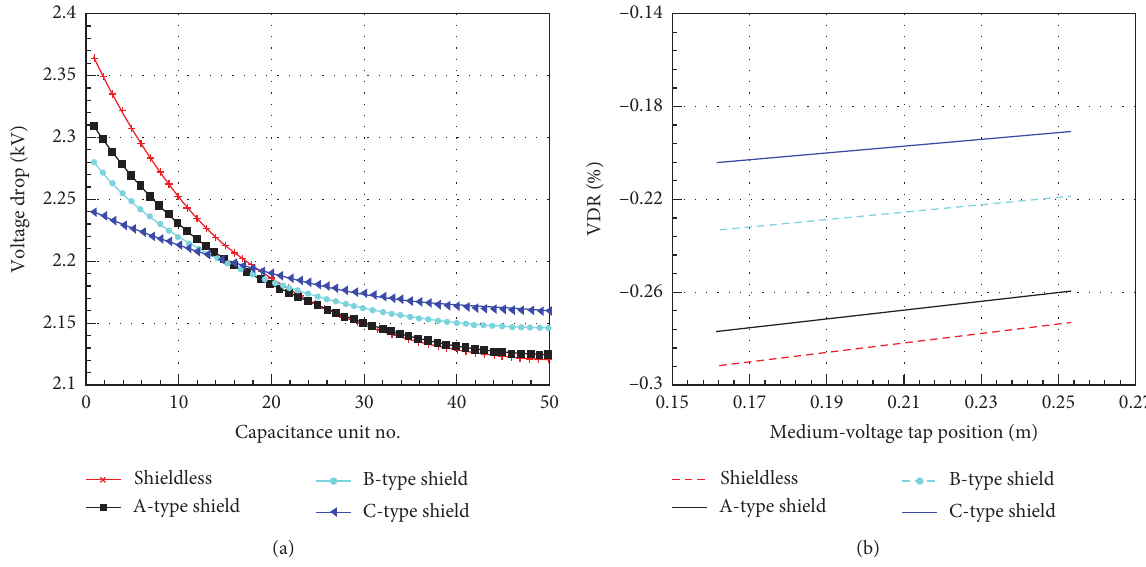
Figure 10: Effect of the shield type on the voltage drop and VDR of the CVD. (a) Voltage drop. (b) VDR.